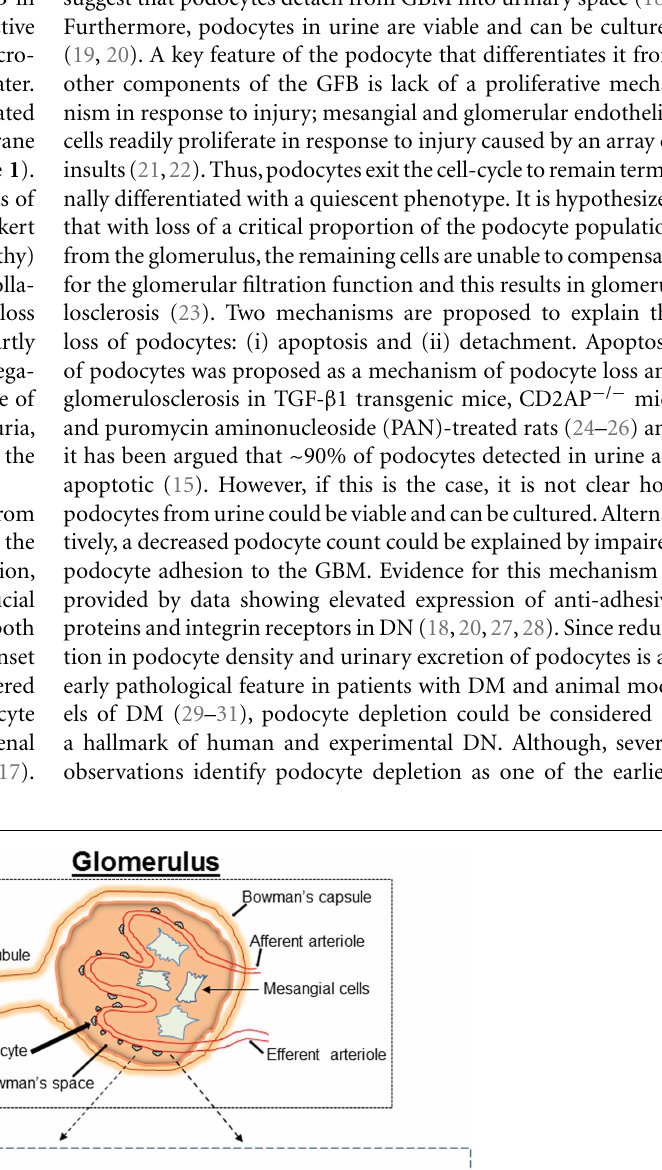
FIGURE 1 | Cartoon depicting the architecture of the glomerulus filtration barrier, which is composed of three layers: the endothelium, glomerular basement membrane, and podocytes . Podocytes extend numerous lamellipodia that branch into primary and secondary processes,